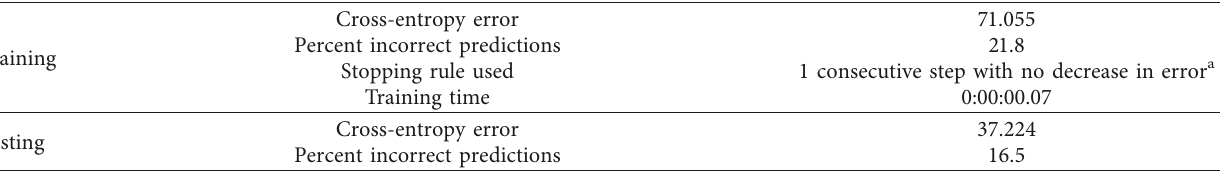
Figure 2: Network diagram. Table 14: Model summary for the neural network